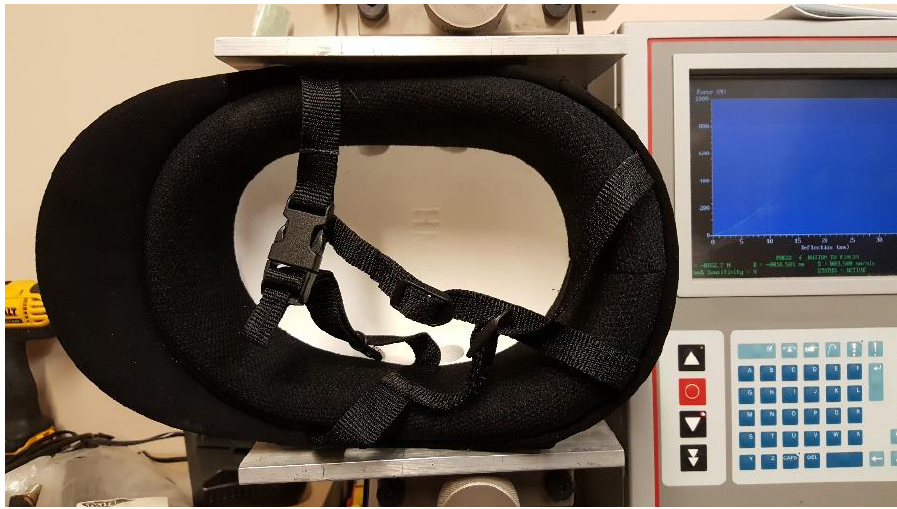
Figure 1. Lateral crush test.